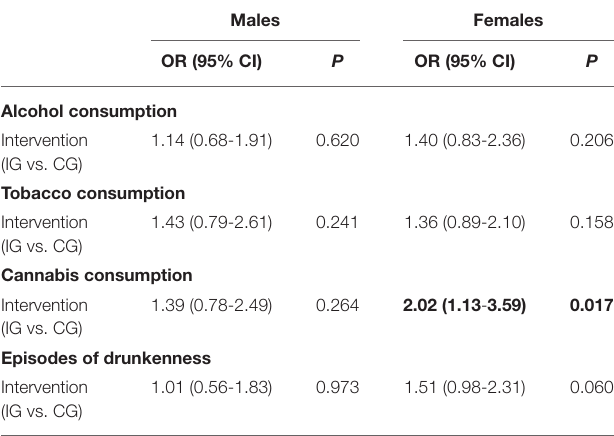
TABLE 5.1 | Gender-specific results of the multivariable logistic regression models; Outcomes: alcohol, tobacco, cannabis consumption, and episodes of drunkenness not increased 5 months